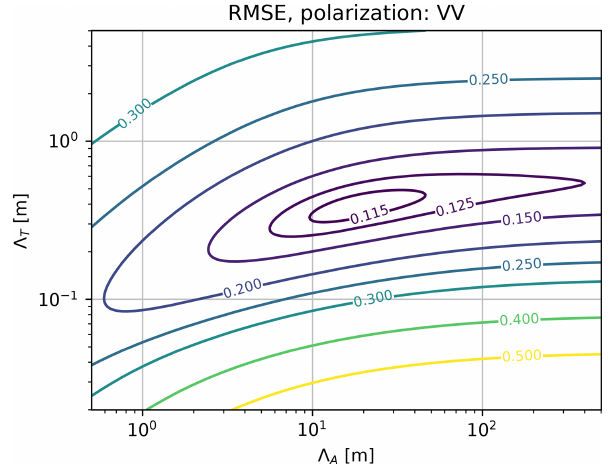
Figure 8. Contour plot of root mean square error (RMSE) between measured and modeled winter data in the Ku-band (Fig. 7) for dif- ferent parameter pairs of (cid:51) A and (cid:51) T . The plot indicates a clear global minimum because the CBOE peak height and hence (cid:51) A can be well estimated due to the availability of ground-based KAPRI measurements at large bistatic angles of β > 1 ◦ .